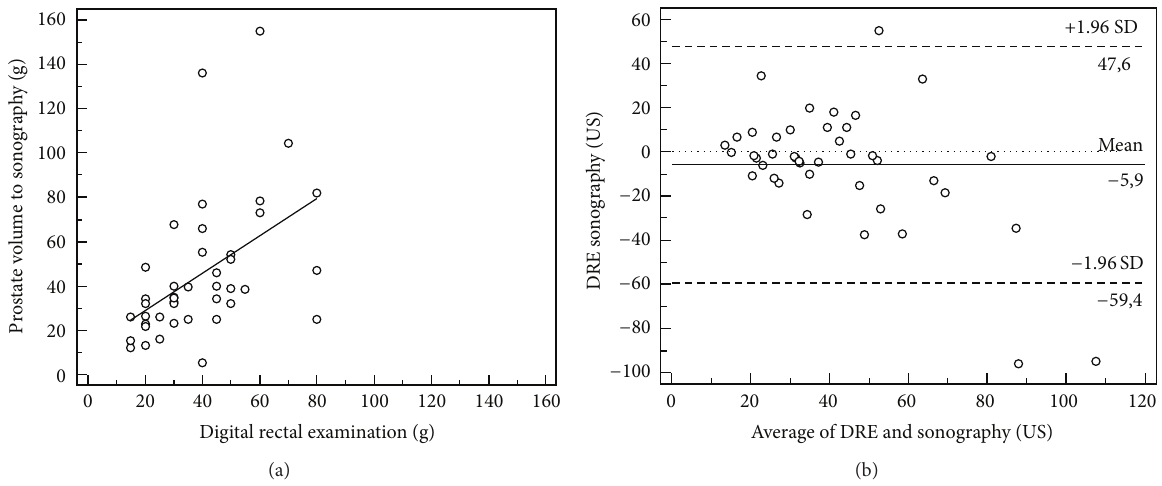
Figure 2: Correlation between prostate volume (PV) estimations by digital rectal examinations (DRE) and ultrasonography (US) and Bland and Altman plot, (1g =